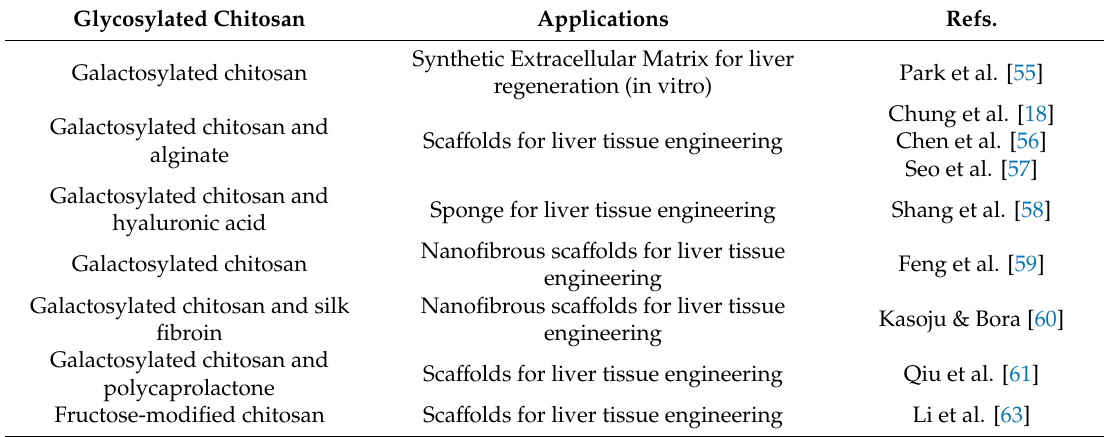
Table 1. Resume of glycosylated chitosans and related Tissue Engineering